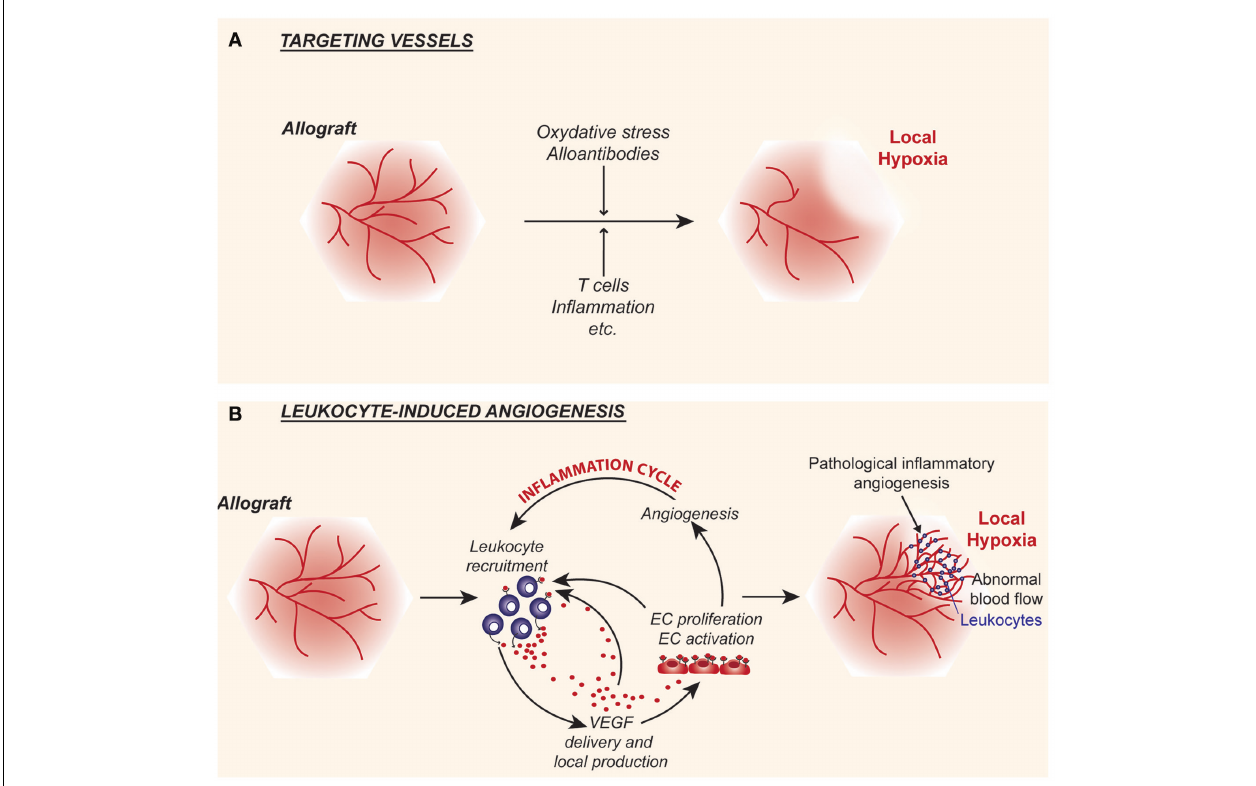
pro-angiogenic factor vascular endothelial growth factor (VEGF) is central to this response. Pathological leukocyte-induced angiogenesis results in the formation of abnormal networks of capillaries that lead to chaotic blood flow patterns and paradoxically results in local hypoxia.Thus, local tissue hypoxia is the end result of acute events and direct targeting of the graft endothelial cells (A) as well as inflammation and the associated leukocyte-induced angiogenesis (B)